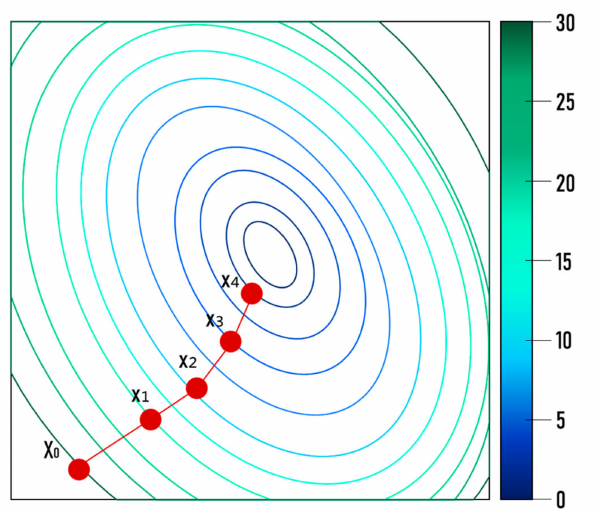
Figure 8. Discrete Armijo gradient algorithm.